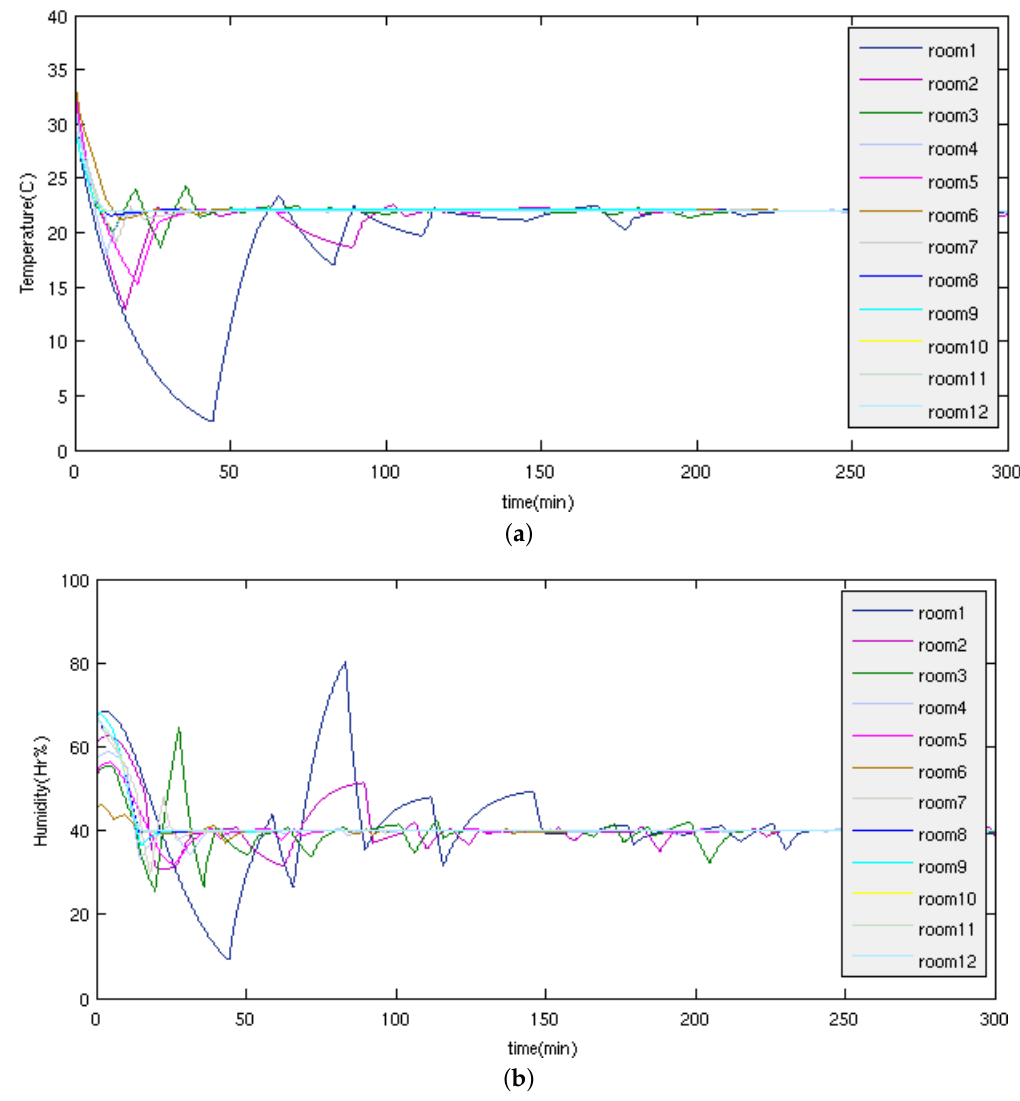
Figure 12. The numerical simulation; colored lines represent Rooms 1 to 12. ( a ) Simulation results of the fuzzy control of room air temperature with temperature disturbances and 70% packet loss. The time evolution of temperature in time for each room; and ( b ) Simulation results of the fuzzy control of room air humidity with temperature disturbances and 70% packet loss. The variation of humidity (RH) in time for each room. The response in both cases includes 70% packet loss on the network and also in the presence of